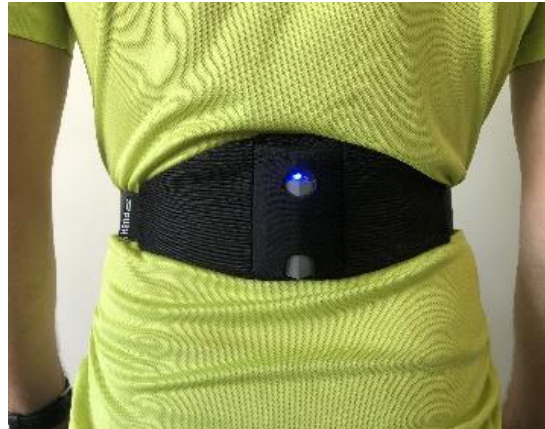
Figure 1. Example of belt location with double-sided adhesive tape between L3 and